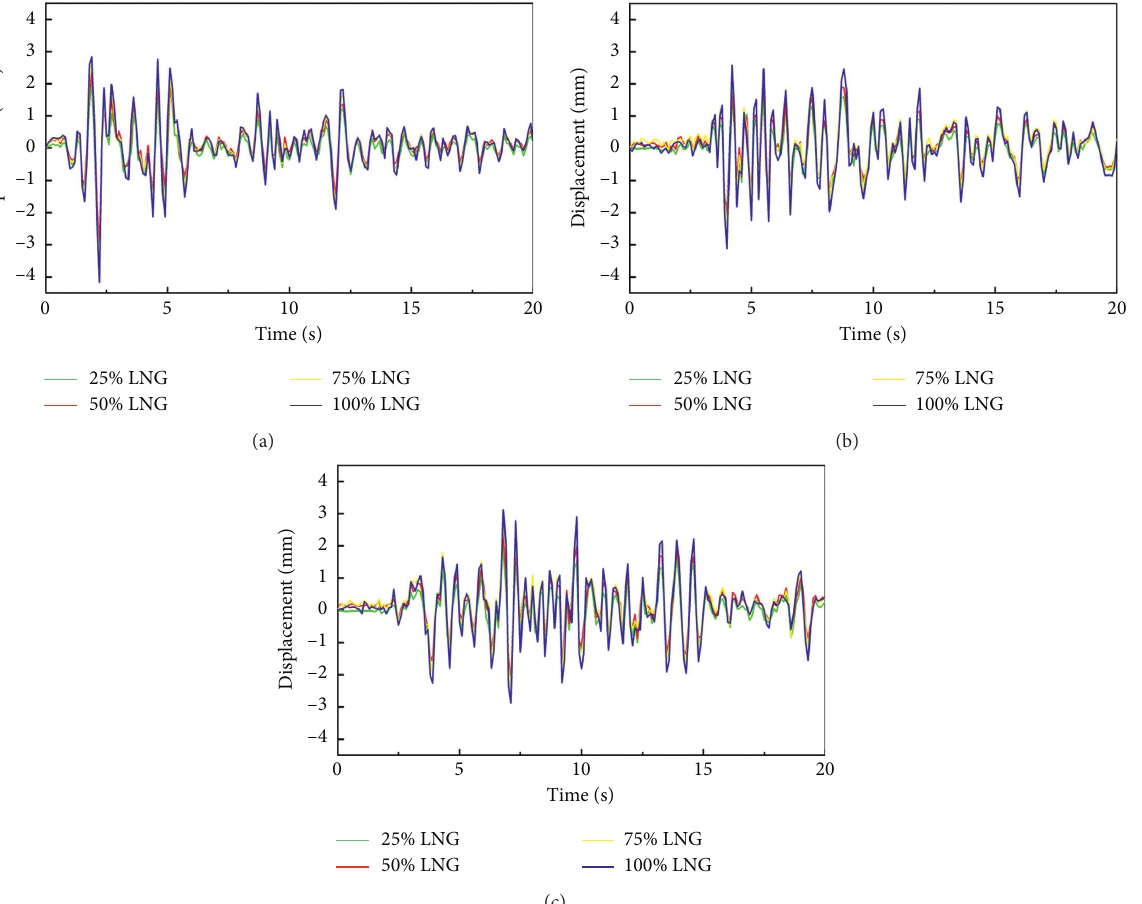
Figure 15: Tip displacement of the outer wall under different liquid volume. (a) El Centro, (b) Northridge, and (c)